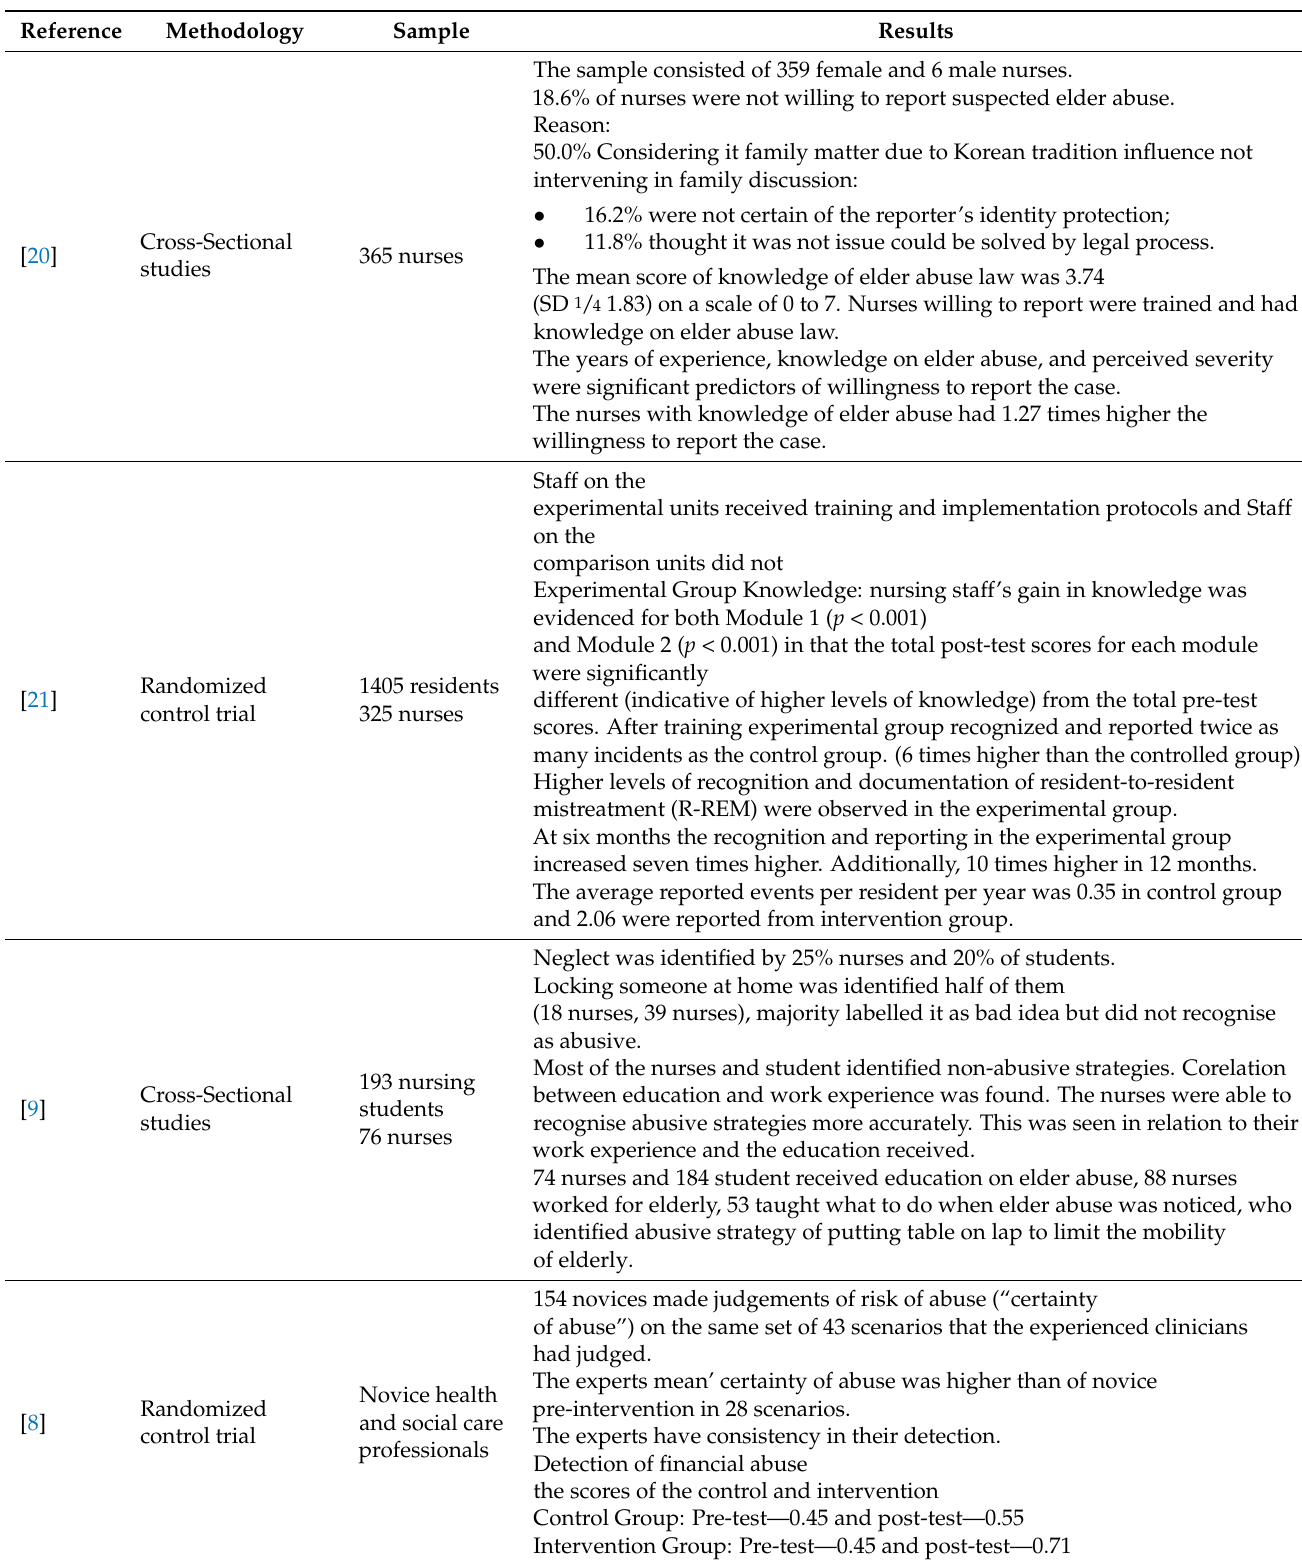
Table 3. Research which evaluated the impact of education about elder abuse on nurses and healthcare